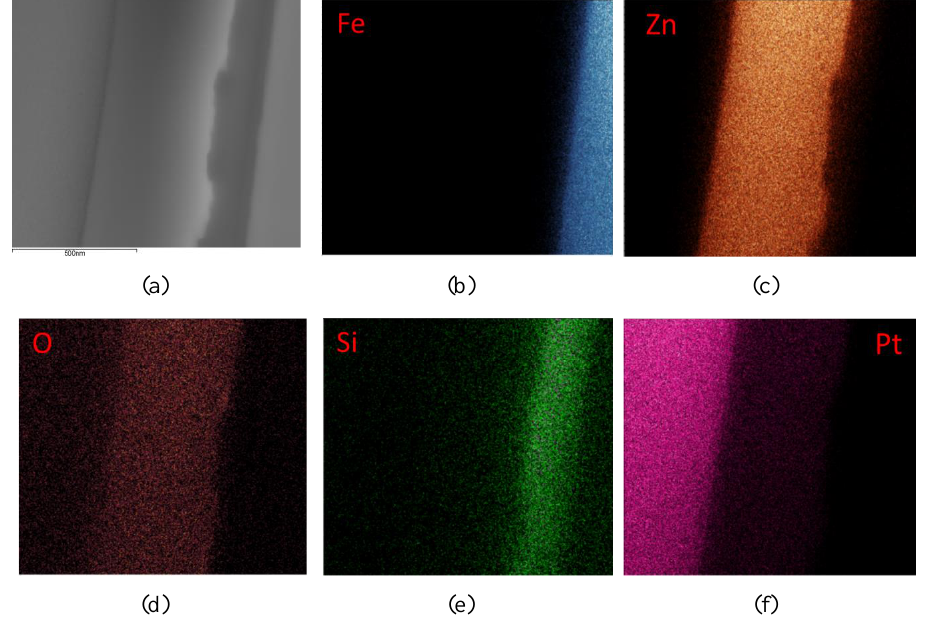
Figure 12. TEM image and EDX analysis of a cross-section through the surface of the Fe–Si–B fibre coated with SiO 2 and ZnO (0.05 M and 24 h). ( a )—TEM image of the cross-section, ( b )—distribution map of Fe, ( c )—distribution map of Zn, ( d )—distribution map of O, ( e )—distribution map of Si, ( f )—distribution map of